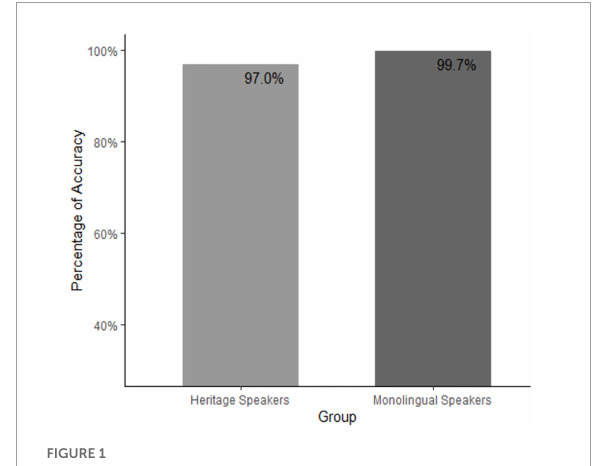
FIGURE1 Percentage of case marking accuracy per group.